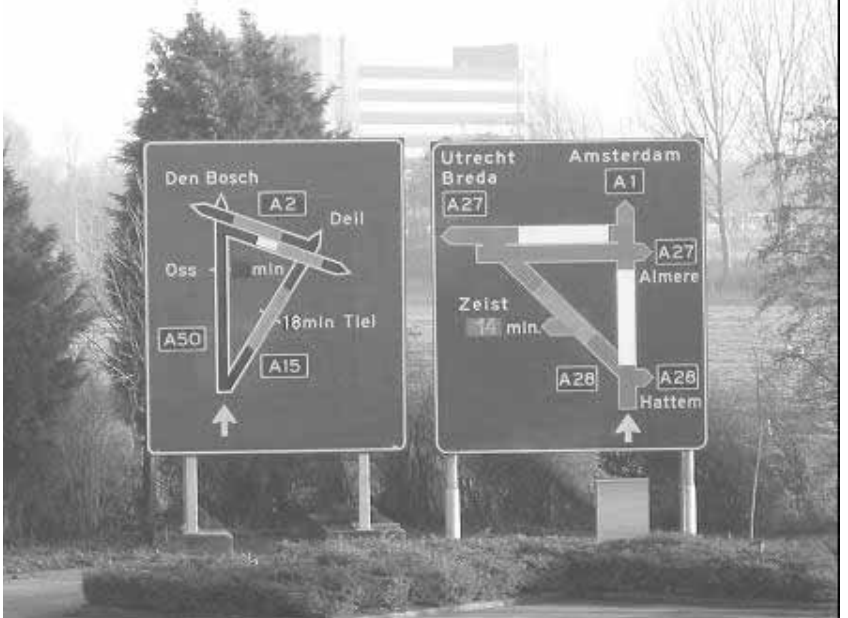
Figure 1a. Example of a Graphical Sign Prototype in the Netherlands (a black default setting may be changed to progressively yellow and red according to congestion